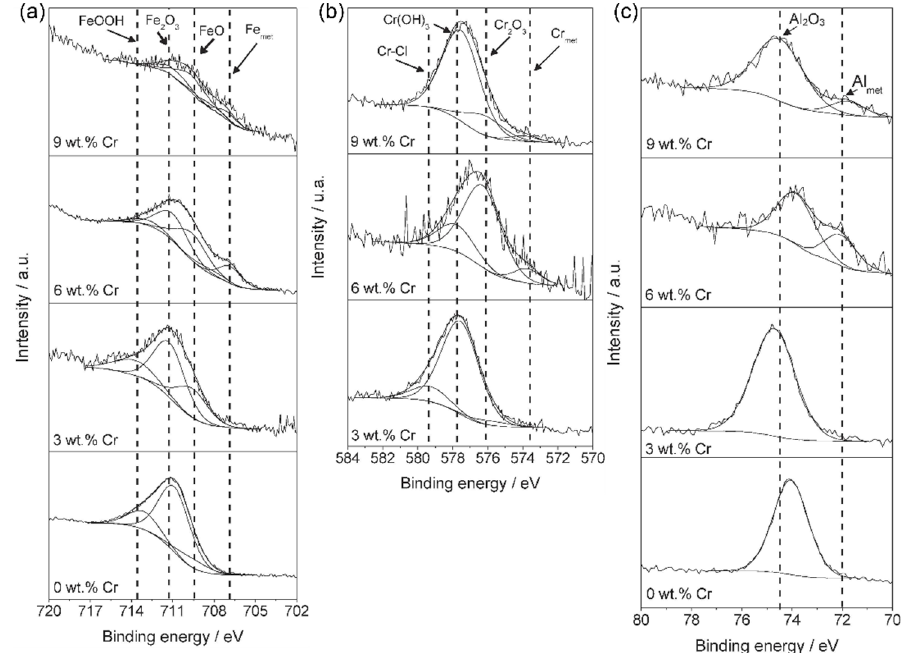
Figure 21. High-resolution XPS spectra for thermo-mechanical processed (TMP) Fe-30Mn-5Al-(0,3,6,9)Cr-0.5C TWIP steels with 0, 3, 6, and 9 wt.% Cr. ( a ) Fe 2p 3/2 , ( b ) Cr 2p 3/2 , and ( c ) Al 2p after exposure to deaerated 0.1 M NaCl solution [85]. (Reproduced with permission from refs. [85]. Copyright (2020), Elsevier).